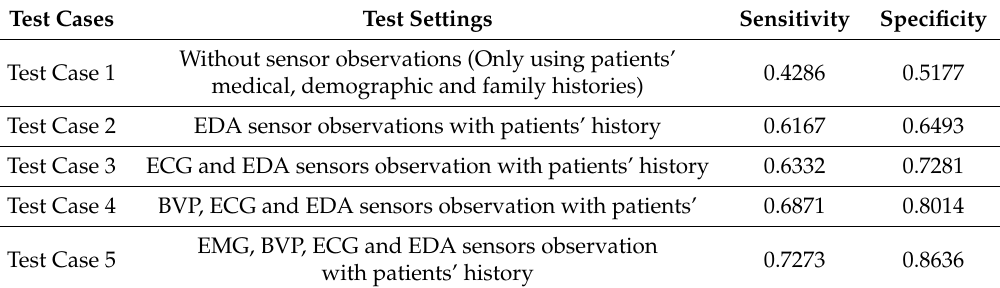
Table 2. Different test settings with performance